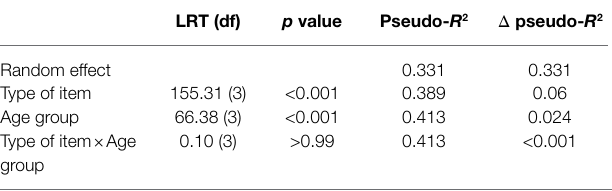
TABLE 7 | Results of the generalized mixed model on accuracy in Experiment 2. LRT (df)